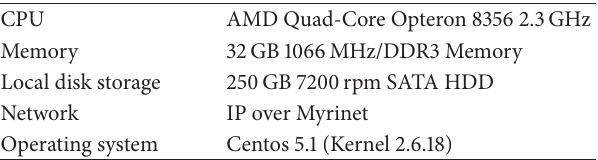
Table 2: Specification of nodes on cluster